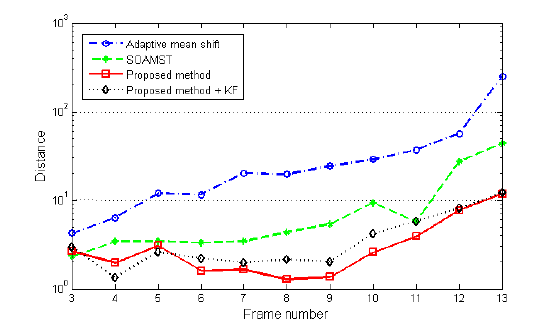
Table 2. Average precision, recall and F-score of the traffic